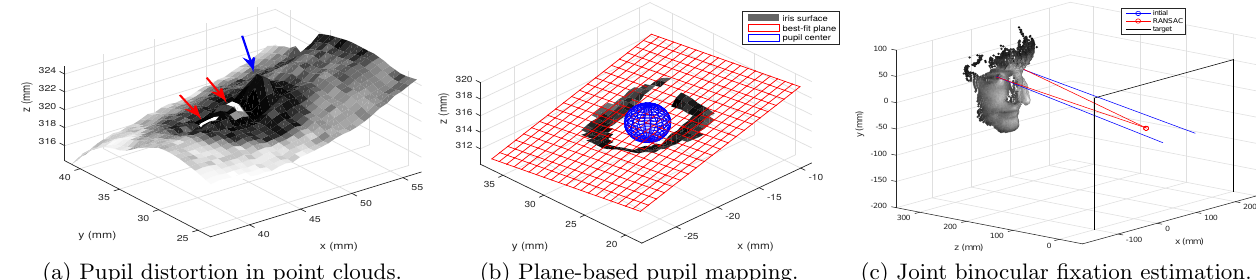
Figure 2: Point cloud fitting in gaze estimation. (a) Eye point cloud surface colored with infrared image showing distorted position near the pupil (blue arrow) and gaps within the pupil (red arrows). (b) Best-fit plane (red) and pupil mapping (blue) for iris region point cloud surface. (c) Example point cloud depicting initial gaze estimates (blue) based on iris plane normals without the fixation constraint and the fixation estimate (red) on the target surface (black).